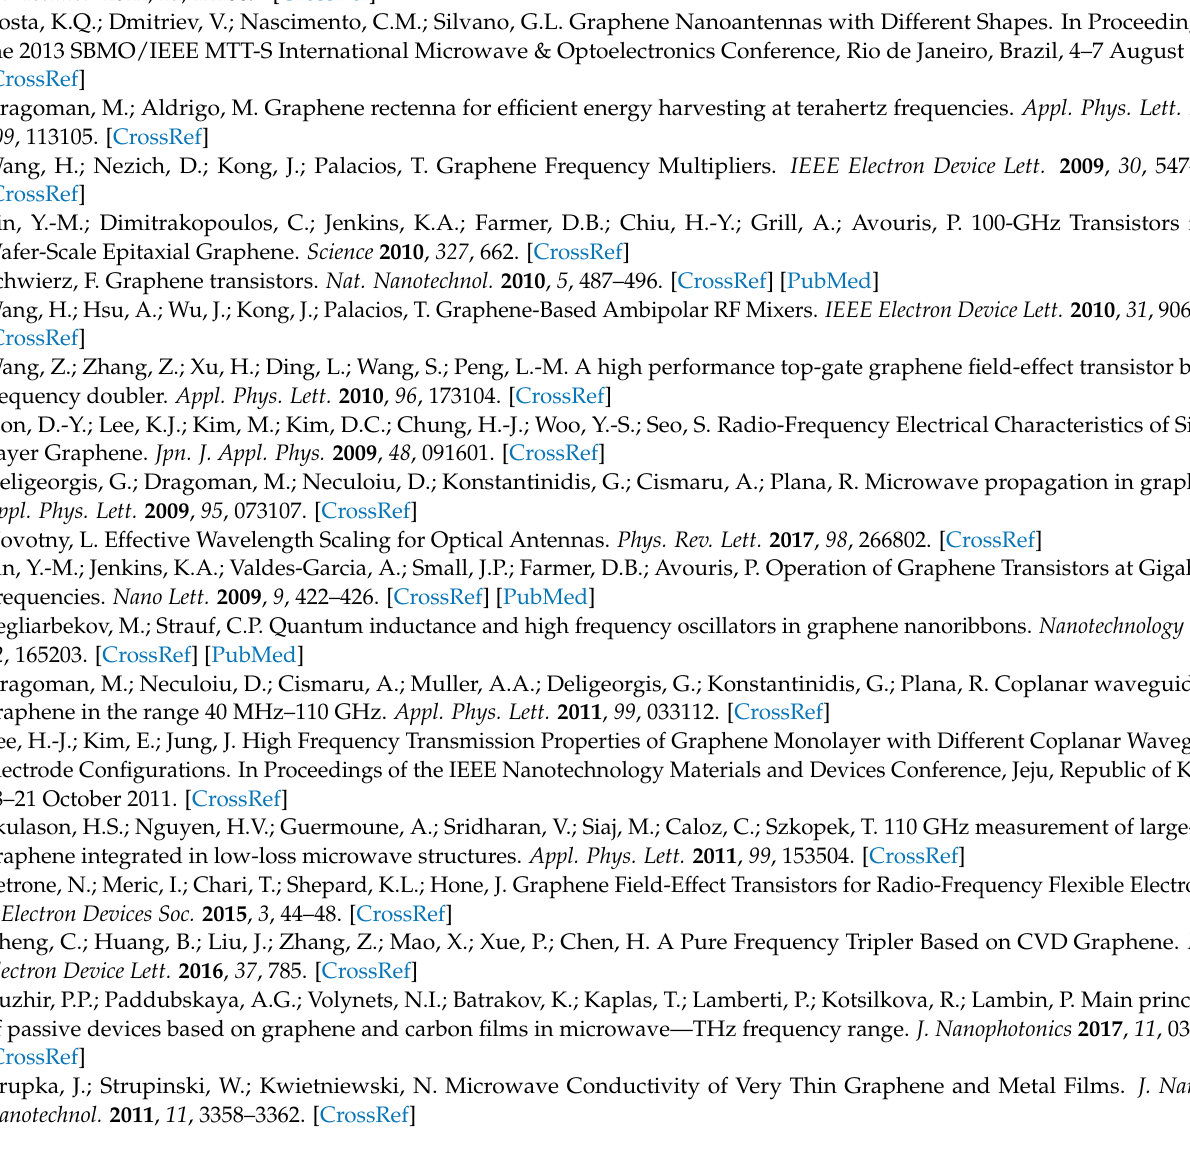
Figure A2. Comparison of capacitance variation of passive devices. ( a ) In Device 1, the capacitance value increases as the distance between the antennas increases. ( b ) For the reference device, there is no capacitance change due to quantum capacitance because graphene is not applied to the device. ( c ) Comparison of capacitance values of Device 1 and Device 2.